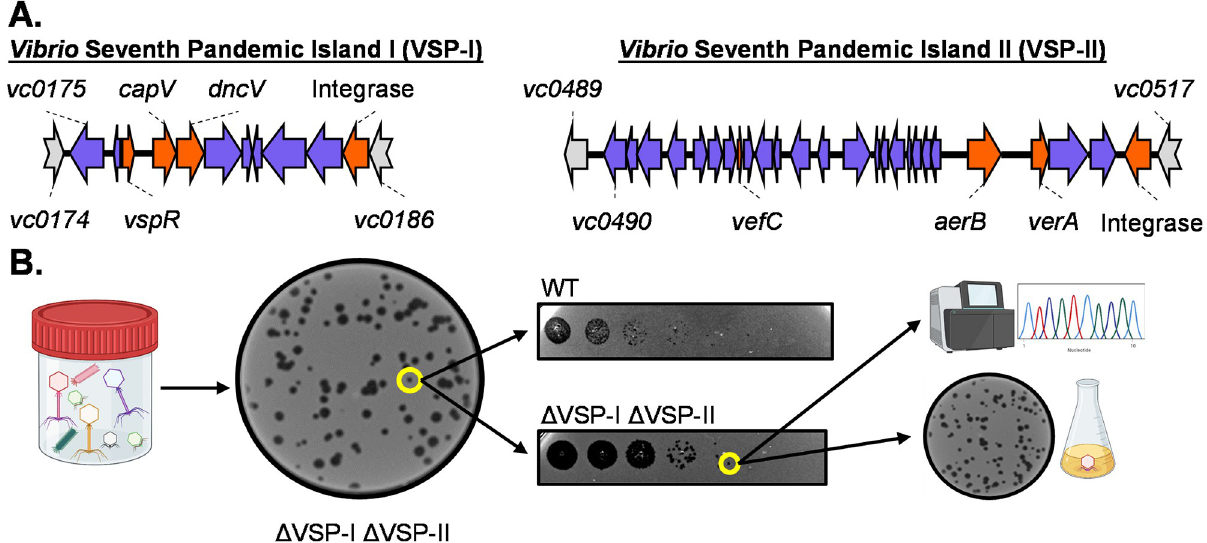
Fig 1. Isolation of VSP-sensitive phages from cholera patient stool samples. (A) Genomic organization of VSP-I &VSP-II, drawn to scale. Genes characterized before this study are marked in orange. Genes on either island with unknown function are blue. Non-VSP genes are grey. (B) Workflow for isolation of VSP sensitive phage. Filter sterilized supernatant from stool samples was plated on a lawn of the Δ VSP-I Δ VSP-II mutant of V . cholerae . Plaques were picked, diluted and spot plated on multiple hosts to identify changes in plaquing. Plaques were picked and plaque purified before sequencing and further downstream assays. This figure is created with